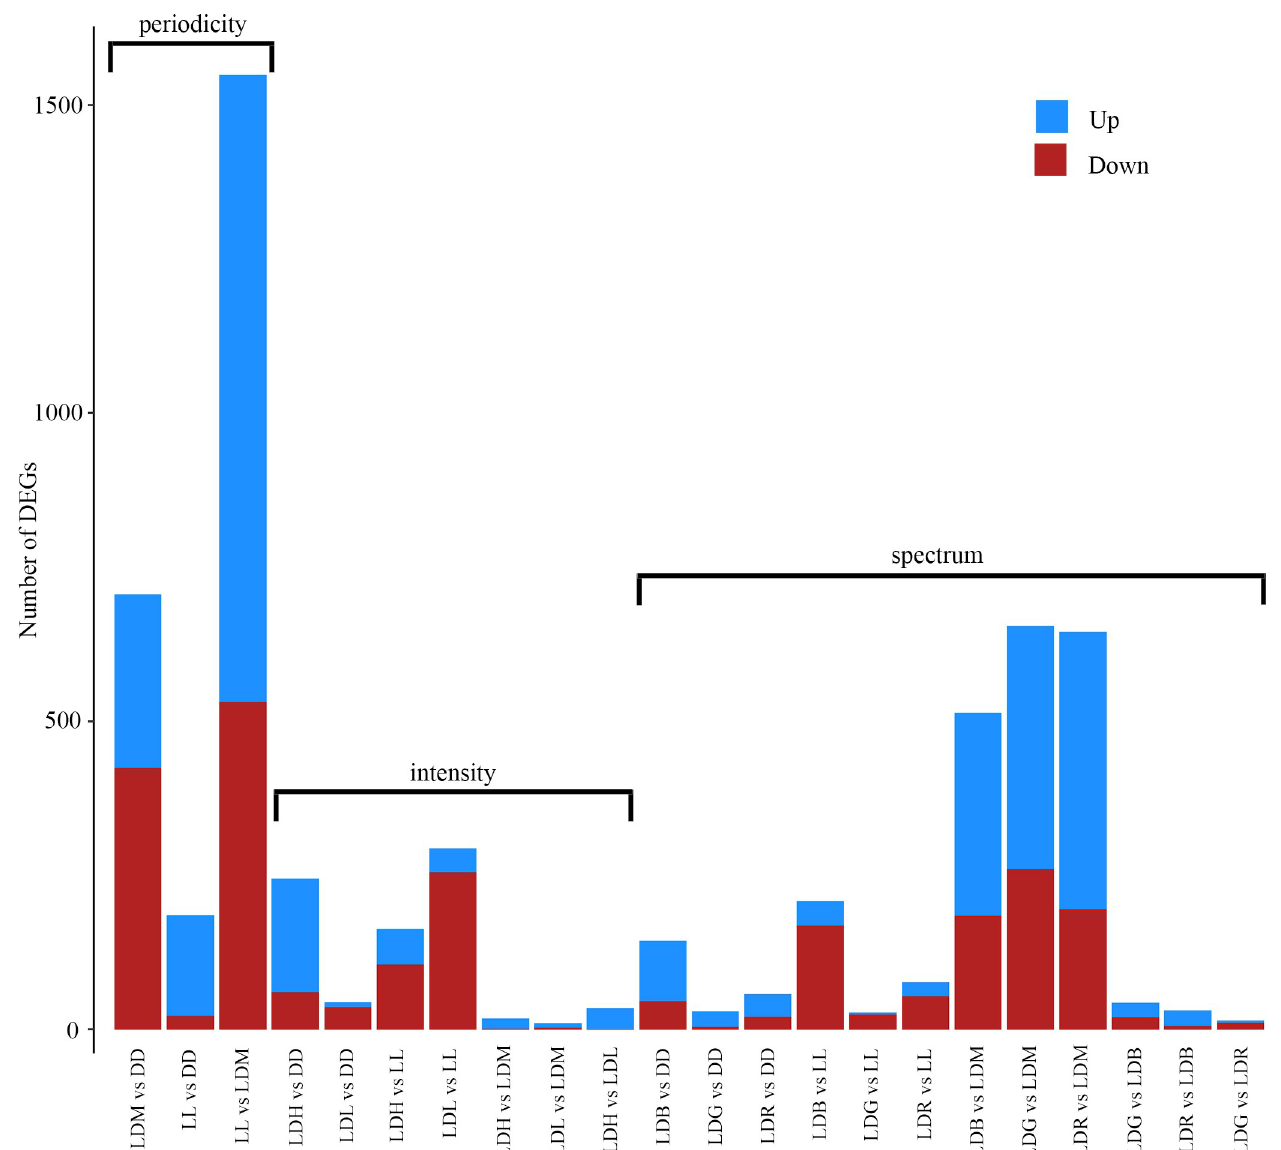
Fig 4. Bar chart comparing differentially expressed genes (DEGs) when 18:00 and 02:00 samples are combined. Many genes are differentially expressed when comparing constant conditions (DD or LL) to LDM. Different intensities of white light had few DEGs when compared to each other. Comparing different wavelengths of light (LDB, LDG and LDR) to LDM gave many DEGs while few DEGs were apparent compared to DD, LL or to each other. LL, LDB, LDG and LDR had the same intensity as LDM.